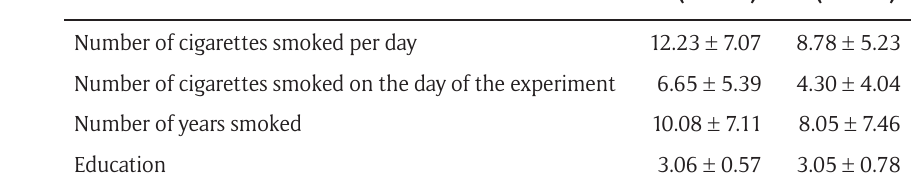
Table 2: Mean scores and standard deviations on secondary variables of Study